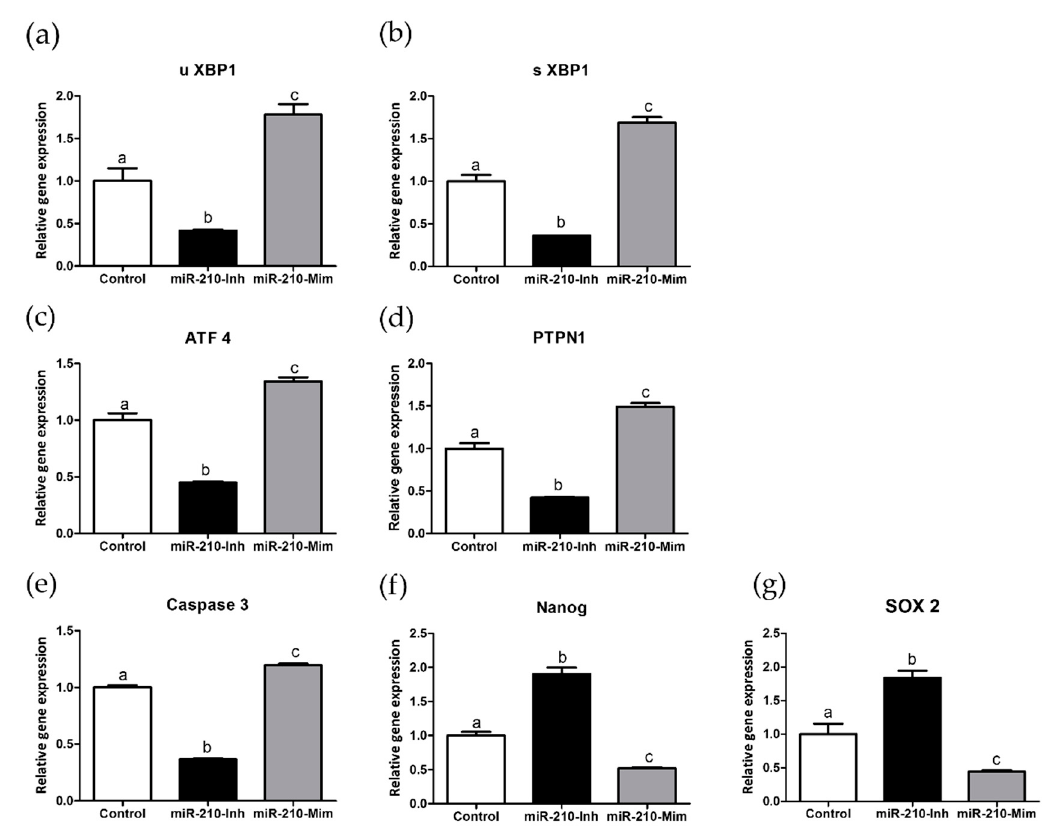
Figure 3. Gene expression levels of uXBP1 , sXBP1 , ATF4 , PTPN1 , Caspase 3 , NANOG , and SOX2 ( a – g ) in microinjected blastocysts. Data information is presented as mean ± SEM. Treatment groups pointed out with letters are considered to be statistically significant ( p < 0.05). At least 70 blastocysts were used in each group, with technical replications repeated in triplicates for the real-time PCR analysis. miR-210-Inh, micro-RNA-inhibitor; miR-210-Mim, micro-RNA-mimic; SEM, standard error of mean.